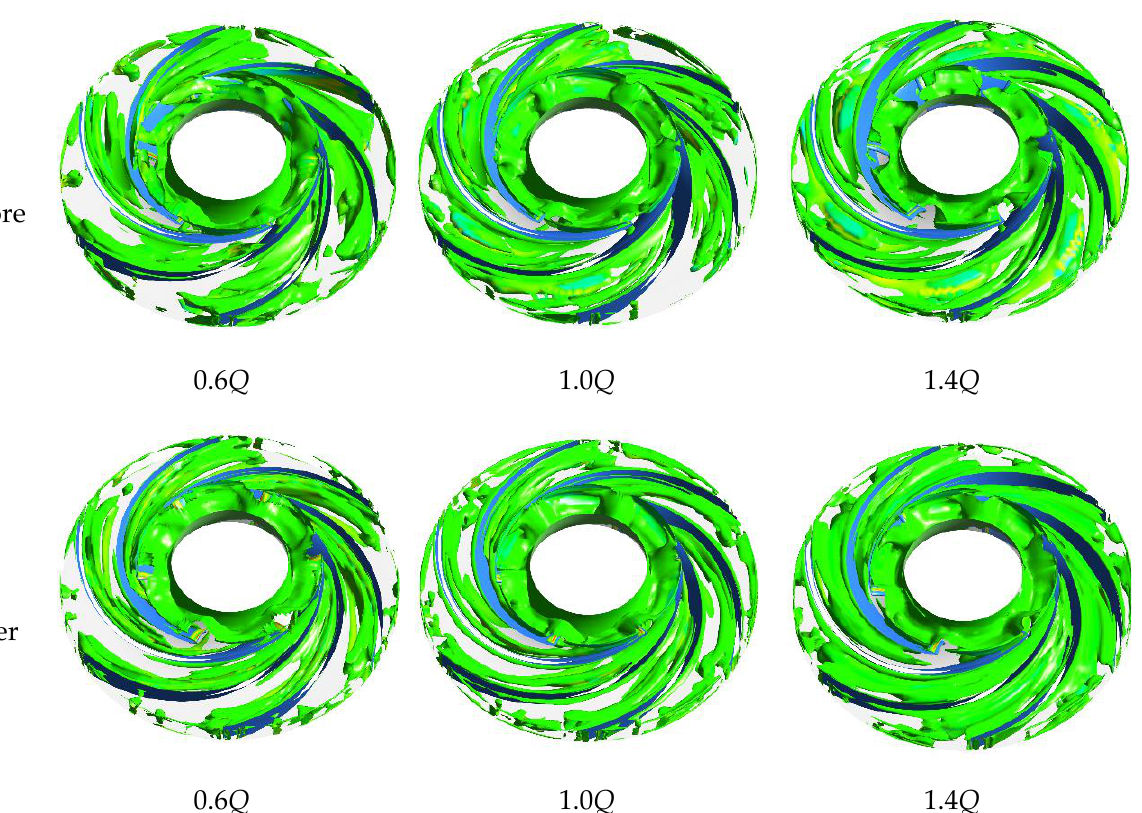
Figure 20. Vorticity distribution of the first-stage impeller before and after optimization.